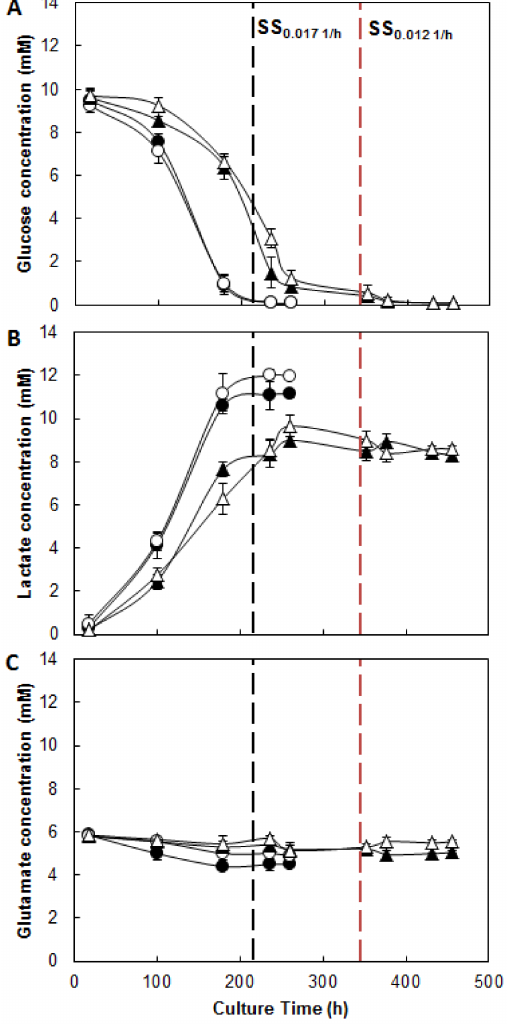
Figure 3. Metabolic profile of CHO cells growing at different culture temperatures and dilution rates. A: Glucose concentration. B: Lactate concentration. C: Glutamate concentration. and 0.017 h 2 1 ; # Condition 33 u C and 0.017 h 2 1 ; m Condition 37 u C and 0.012 h 2 1 ; n Condition 33 u C and 0.012 h 2 1 . Black dotted line: Start of SS 0.017 h 2 1 . Red dotted line: Start of SS 0.012 h 2 1